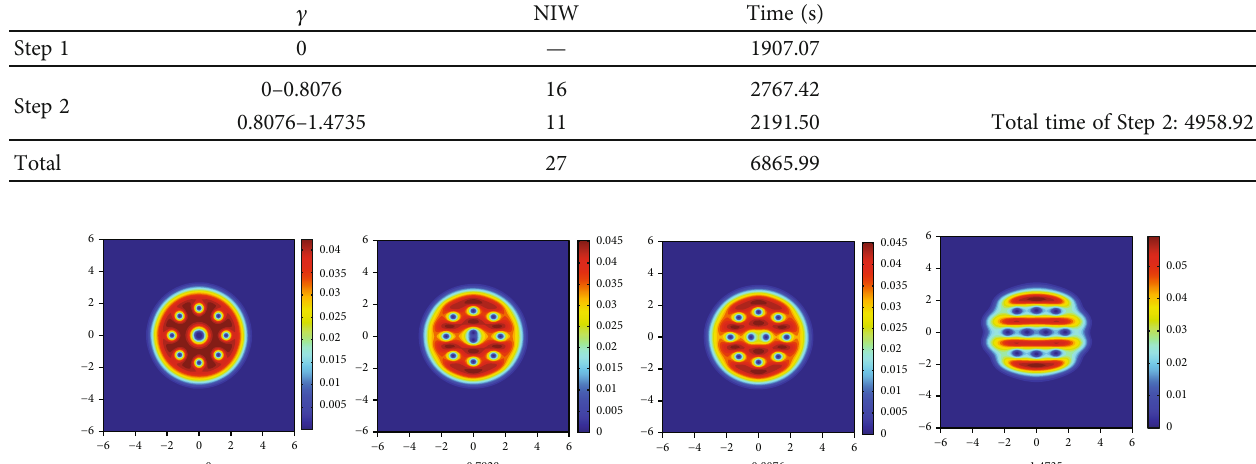
ð x , y Þ = ð 1 : 003 x 2 + 0 : 997 y 2 Þ /2 + ð 1 : 003 x 2 + 0 : 997 y 2 Þ 2 /4 , 2